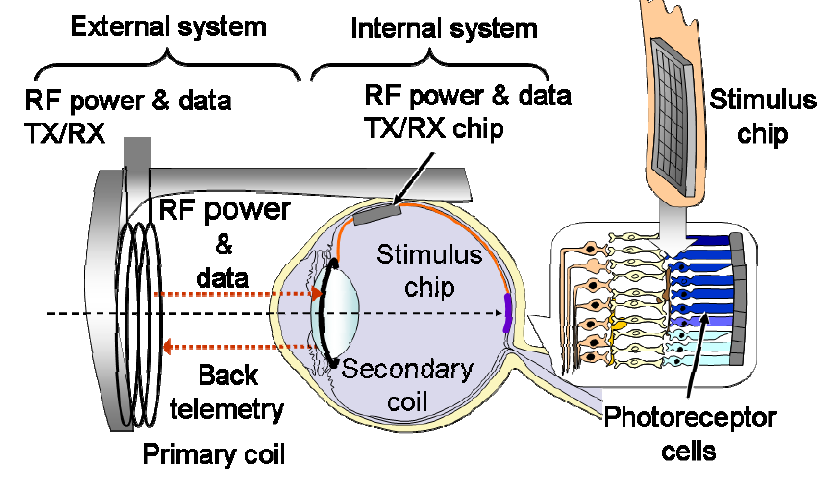
Figure 7. Typical configuration of an intraocular retinal prosthesis system (adapted from [3] © 2009